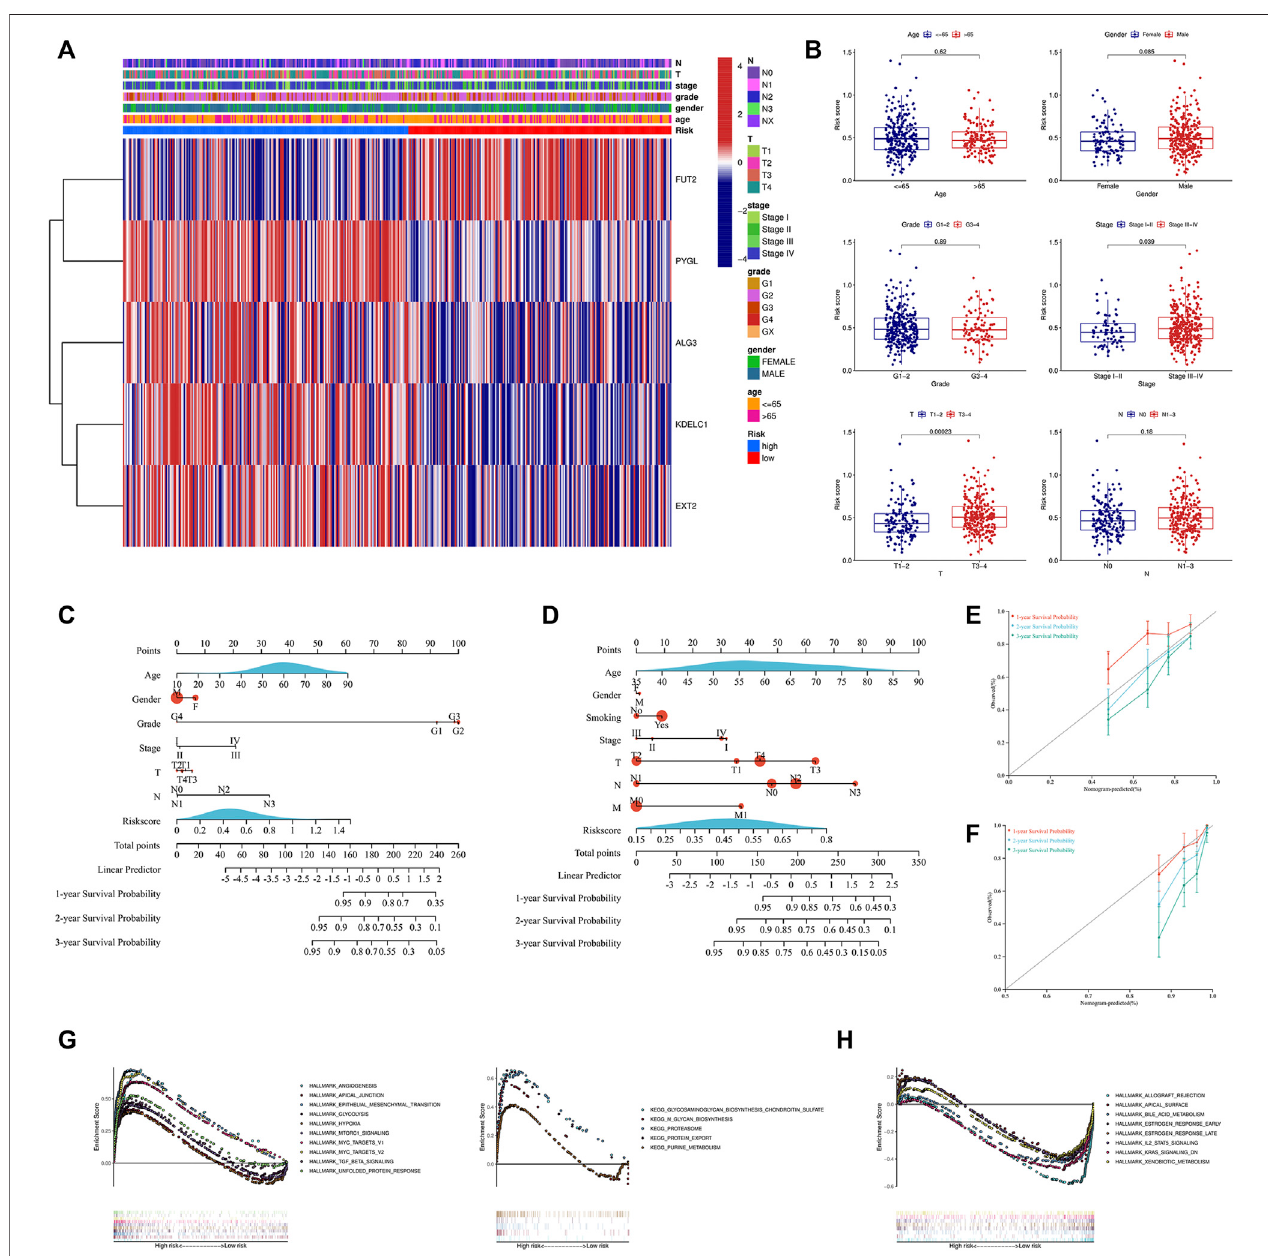
FIGURE 5 | Analysis of the signature and clinical parameters. (A) Distribution of the clinical parameters and the expression of the fi ve genes between the two groups. (B) Difference analysis of the risk score grouped by the clinical parameters. Construction of the nomogram combined with the risk score and the clinical parameters in the training cohort (C) and GSE65858 validation cohort (D) . Calibration curve of the nomogram at 1-year, 2-year and 3-year survival in the training cohort (E) and GSE65858 validation cohort (F) .Pathwaysenriched in thehigh-risk group (G) and low-risk group (H) throughGSEA. GSEA, geneset enrichmentanalysis.